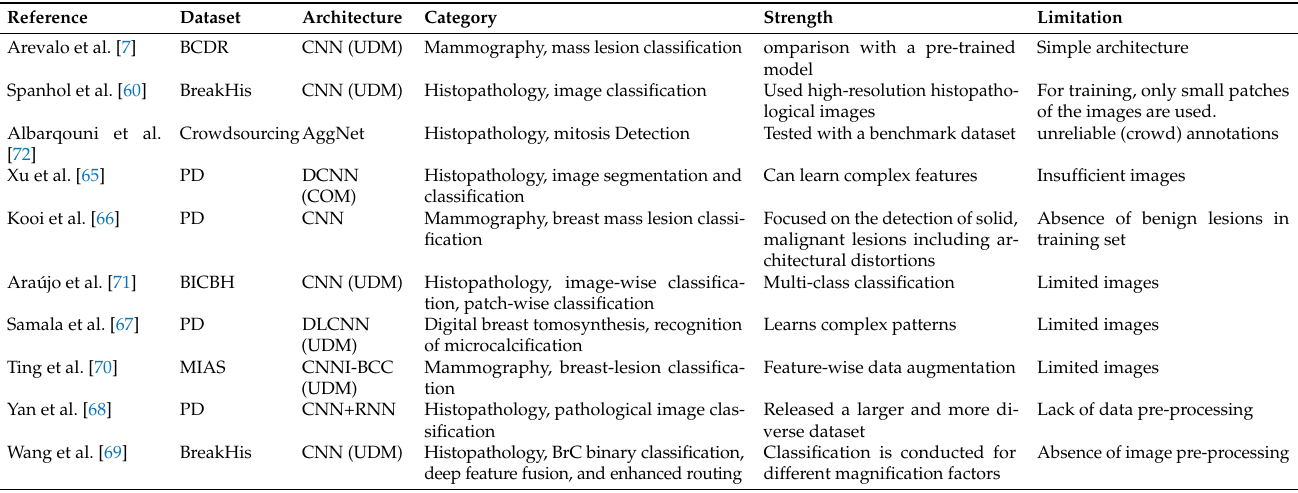
Table 5. State-of-the-art studies based on De-novo